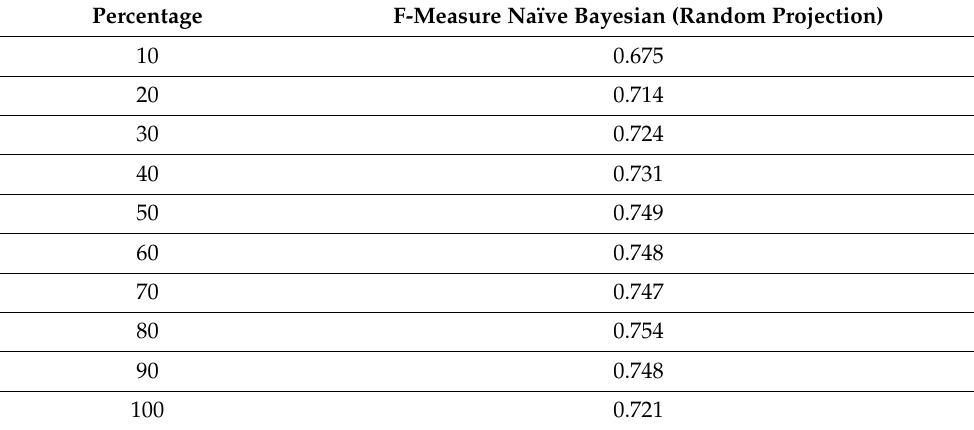
Table 3. F ‐ measure for Naïve Bayesian with a random projection. Table 3. F-measure for Naïve Bayesian with a random